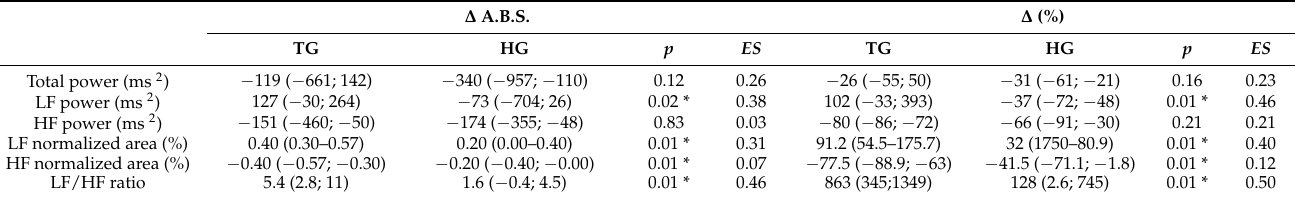
Table 3. Median (25th, 75th percentiles) of absolute ( ∆ ABS) and relative ( ∆ %) changes from the supine to the orthostatic positions of the frequency-domain indices of the triathlon group (TG; n=16) and the high-intensity interval training combined with different types of exercises group (HG; n = 18). Legend: * Value statistically different ( p ≤ 0.05) when compared with triathlon group by